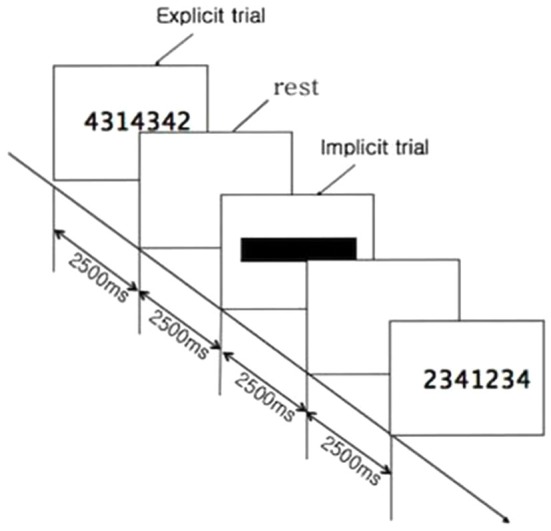
Time sequence of motor task. When combination of numbers appeared, participants were instructed to hit the 1st number as quickly as possible and push the remaining 6 numbered buttons for 2500 ms, which was explicit trial. It was followed by a rest for 2500 ms. After a rest, the numbers appeared again, but at this time they were blocked by a black bar. Subjects were instructed to strike the 7-digit sequence of numbers as quickly and accurately as possible, on the basis of memory for 2500 ms. That was defined as the implicit trial. The 2500 ms × 4 cycle was repeated 8 times. A 20 s rest followed. This set was repeated 8 times.